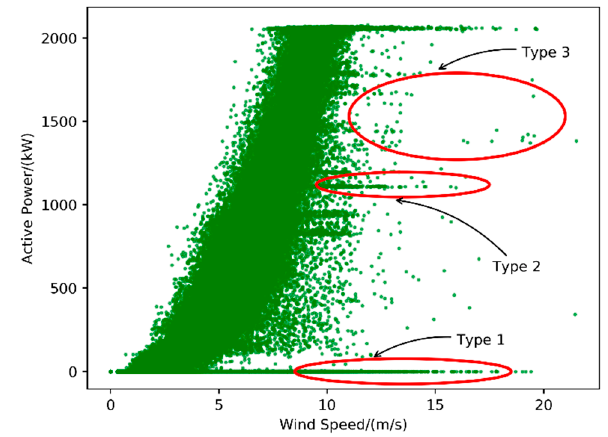
Figure 1. Three common types of anomaly data in the power curve.